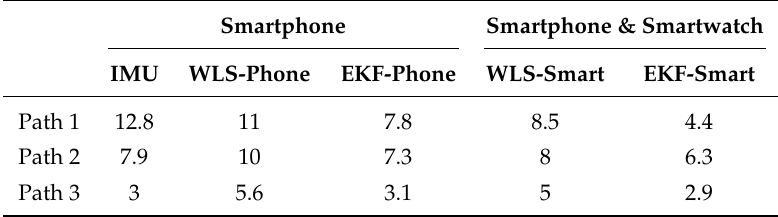
Table 2. Results of the experimental validation in terms of the 90